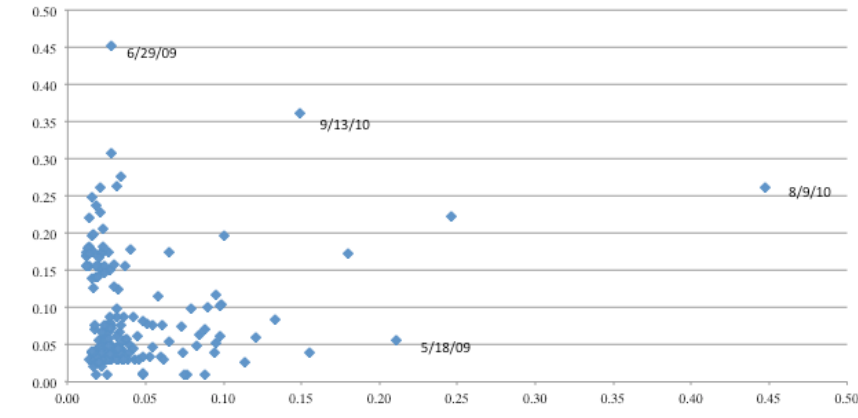
Fig. 4. Concentration comparison of HCB (y-axis) and γ -HCH (x-axis) in air samples from Troll (Antarctica: 2007–2010).